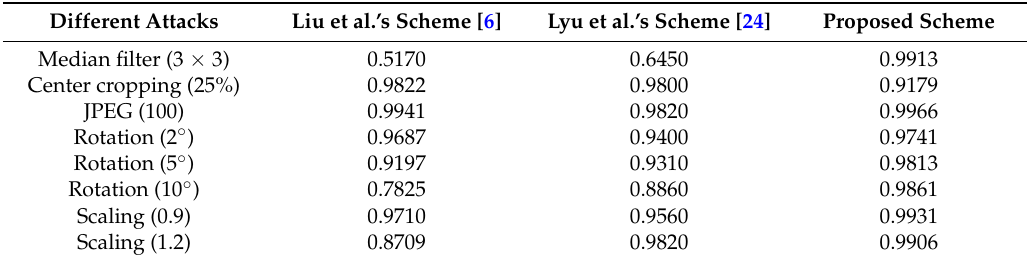
Table 4. Comparisons in watermark robustness aganist different attacks among Liu et al.’s scheme [6], Lyu et al.’s scheme [24], and the proposed